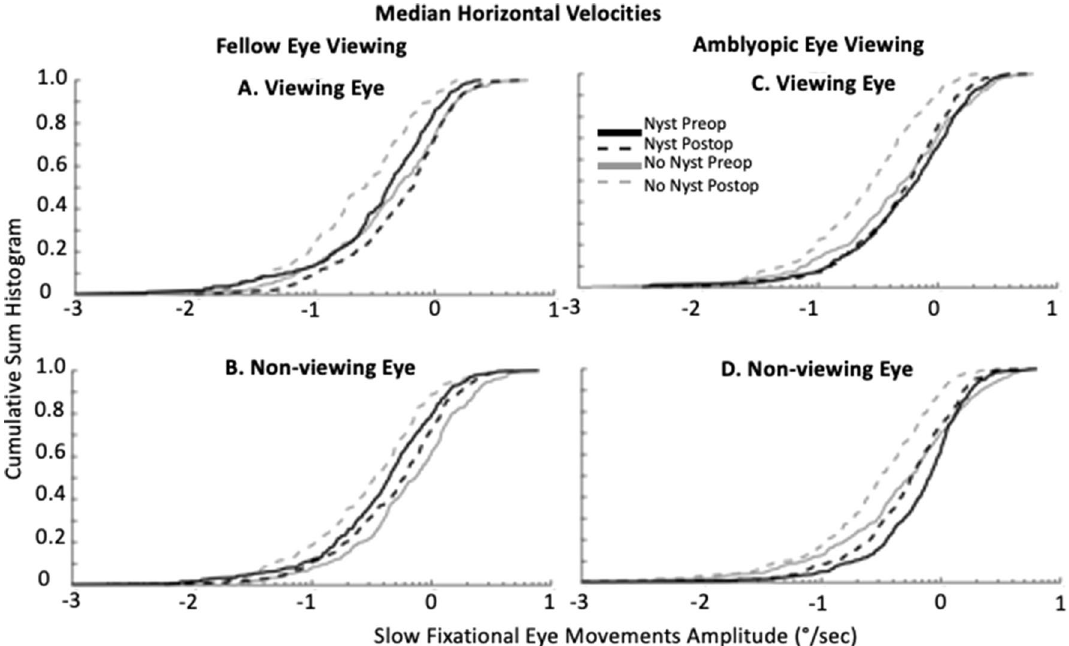
Figure 6. Cumulative sum histograms of median horizontal velocities (°/s) of the viewing and non-viewing eye during fellow eye ( A viewing eye, B non-viewing eye) and amblyopic eye ( C viewing eye, D non-viewing eye) viewing conditions, produced during a gaze-holding task. Solid lines represent pre-operative data (grey = no nystagmus, black = with nystagmus), and dashed lines represent post-operative data (grey = no nystagmus, black = with nystagmus). X-axis is log scale. Amblyopic eye viewing Fellow eye viewing Preop Postop p value Preop Postop p value Horizontal drift velocity (°/s)—subjects without